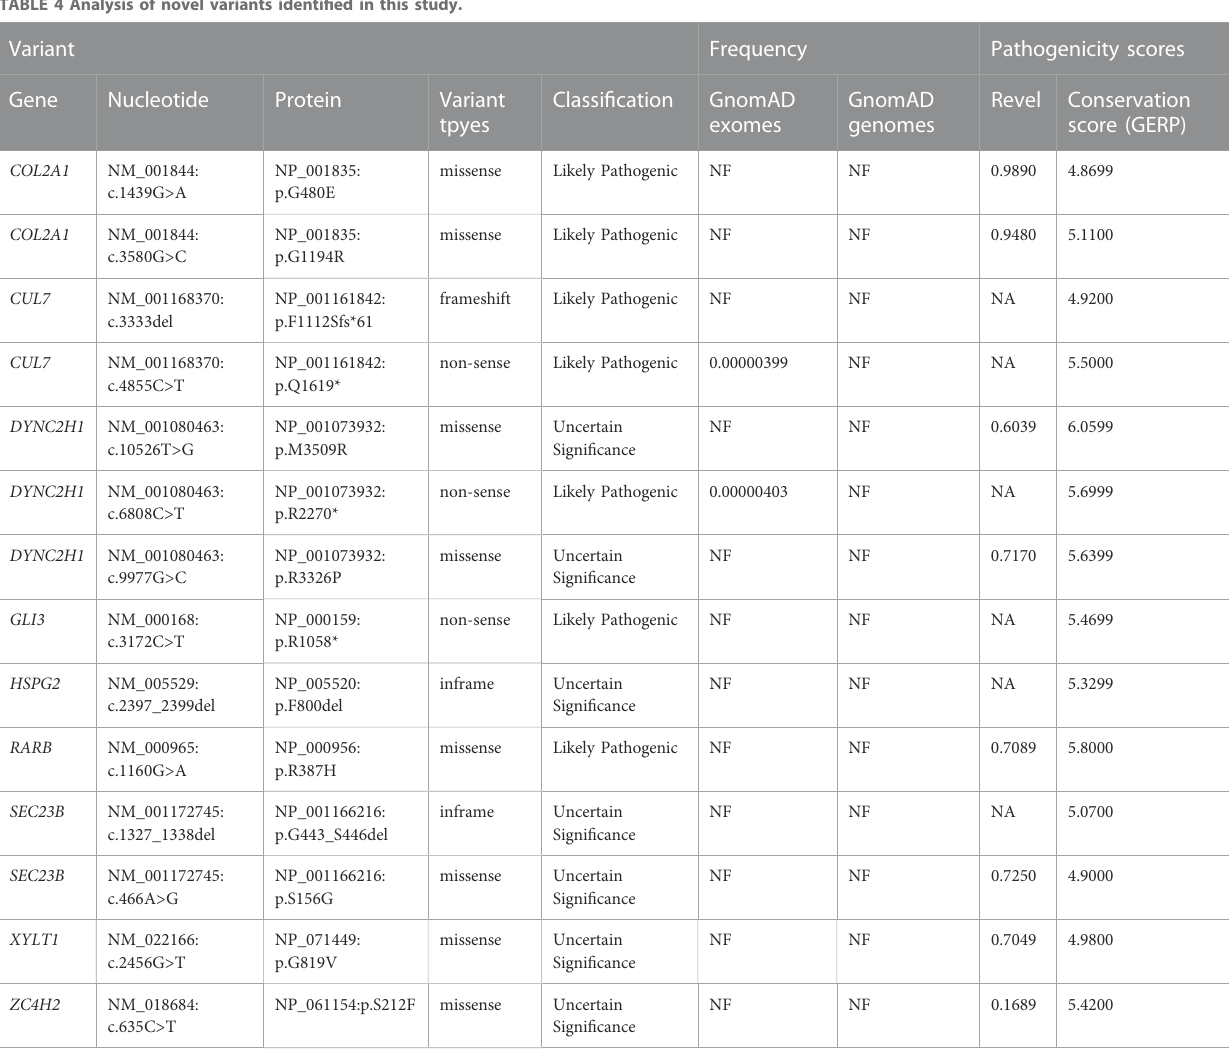
TABLE 4 Analysis of novel variants identi fi ed in this study.